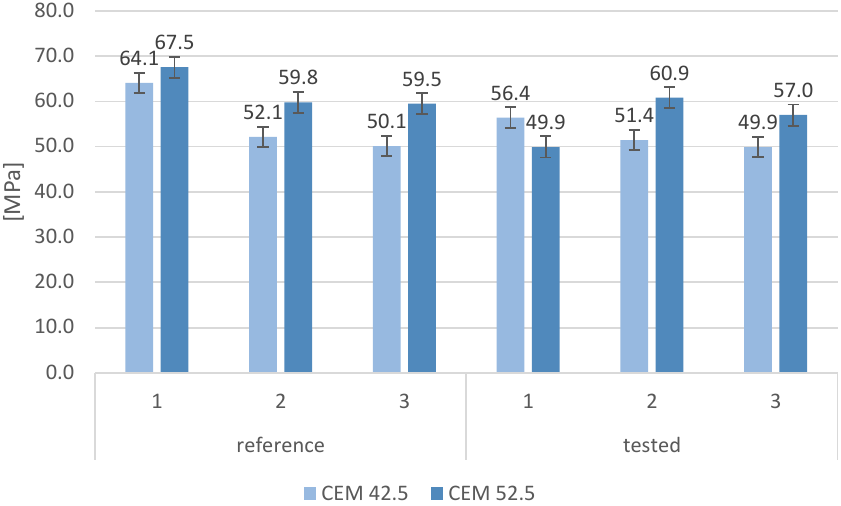
Figure 10. Compressive strength of samples after frost testing and compressive strength of reference samples.